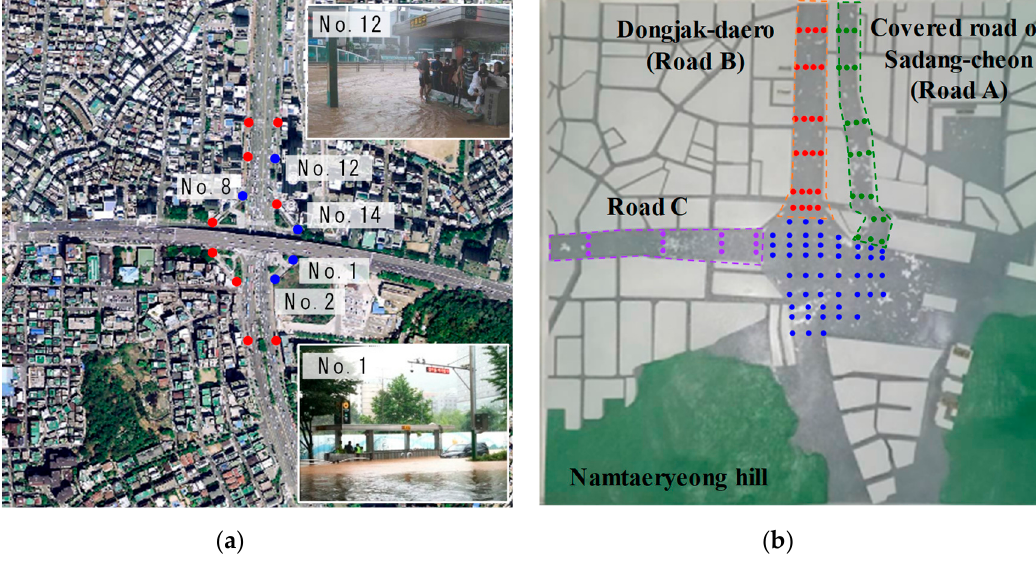
Figure 4. Descriptions of Sadang-Cheon area: ( a ) aerial photo of study area; ( b ) scale model.